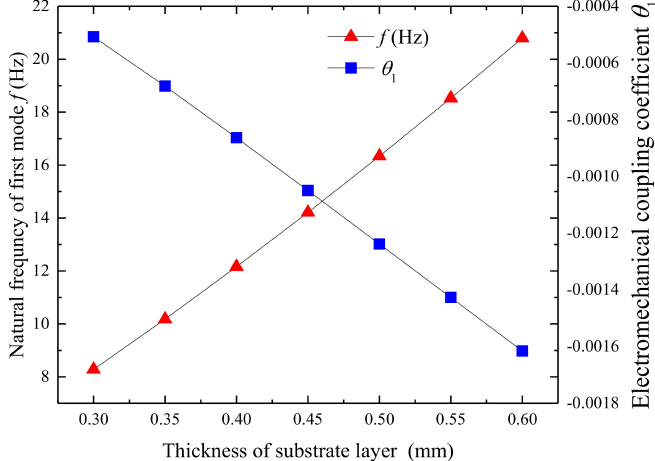
Figure 7. Variation of the first natural frequency and electromechanical coupling coefficient of UPEH as a function of the thickness of substrate